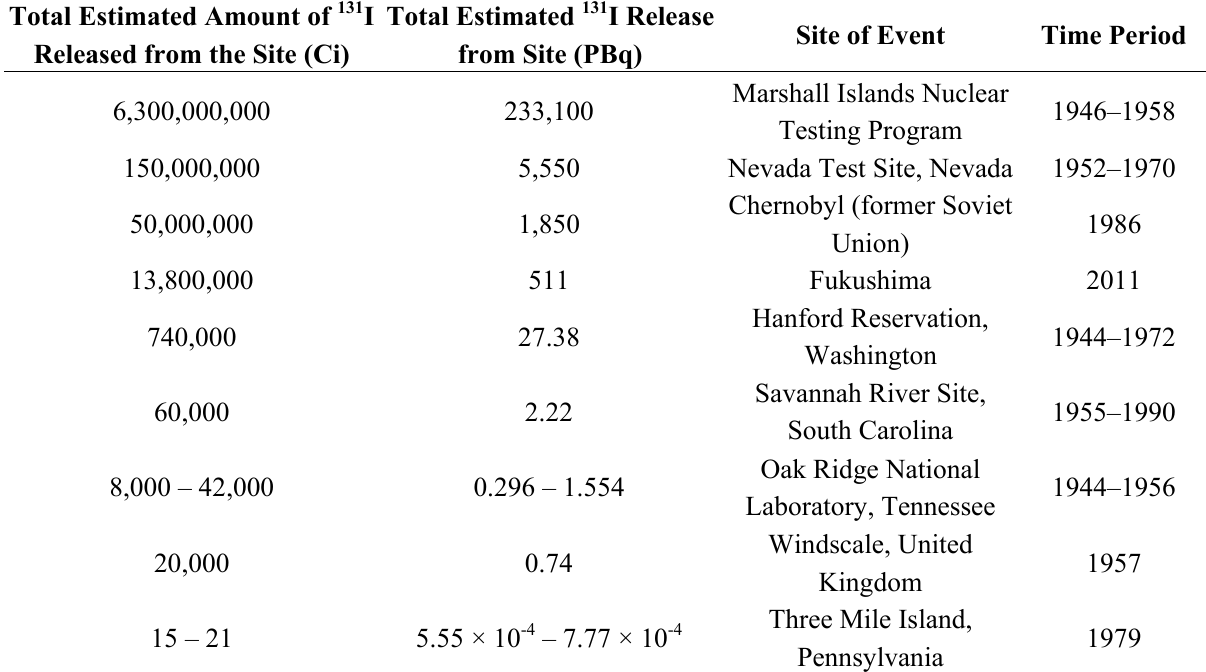
Table 4. Iodine 131 historic